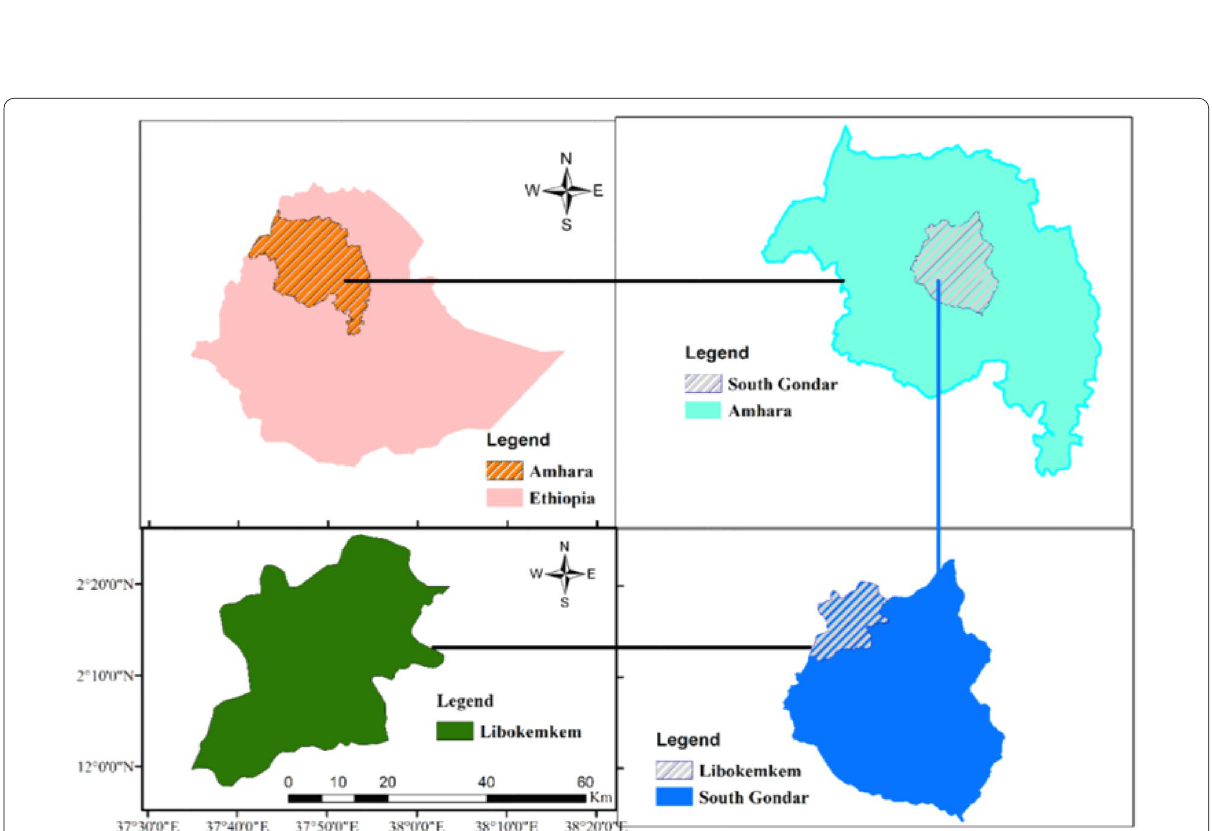
Fig. 2 Map of the study